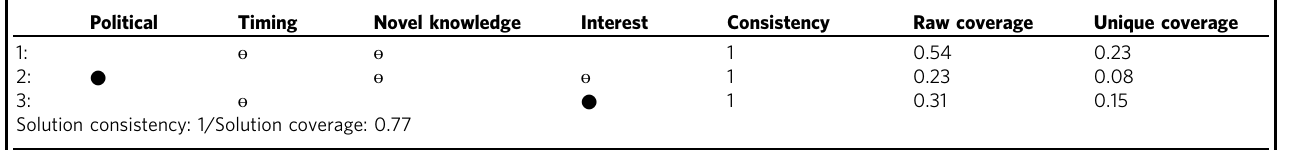
Table 5 Suf fi ciency analysis for the absence of